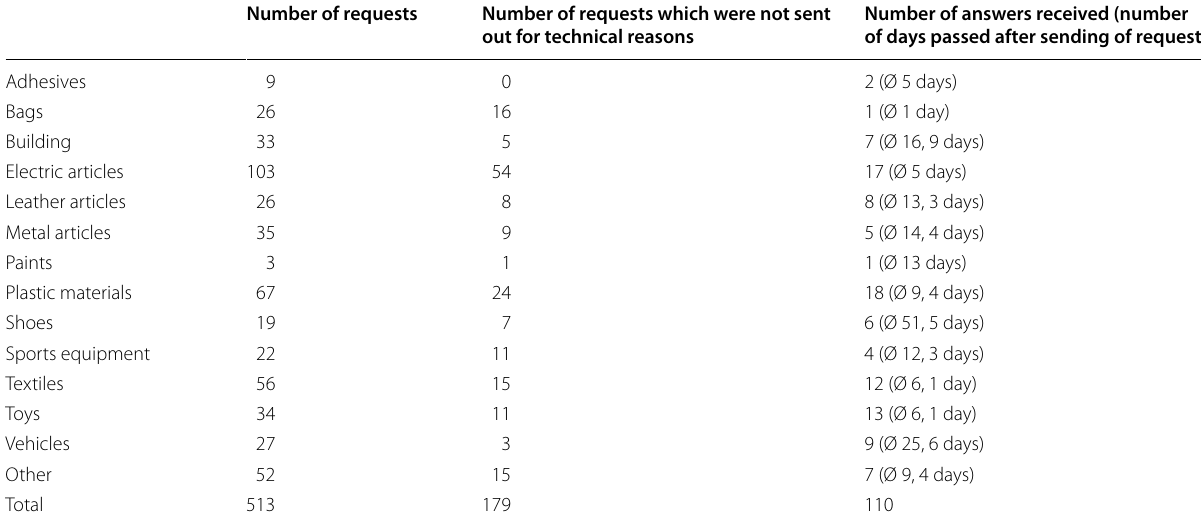
Table 2 Information requests conducted for 513